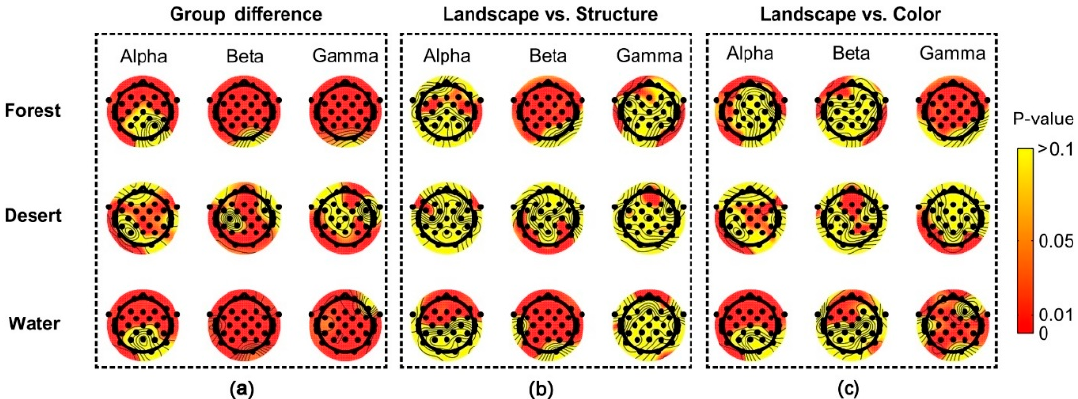
Figure 8. The difference in distribution of brain waves among scenarios in different landscape types. Landscape indicates landscape images, Structure indicates structure images, and Color indicates color images. ( a ) the group differences among different landscape types, ( b ) the difference between landscape images and structure images, ( c ) the difference between landscape images and color images.